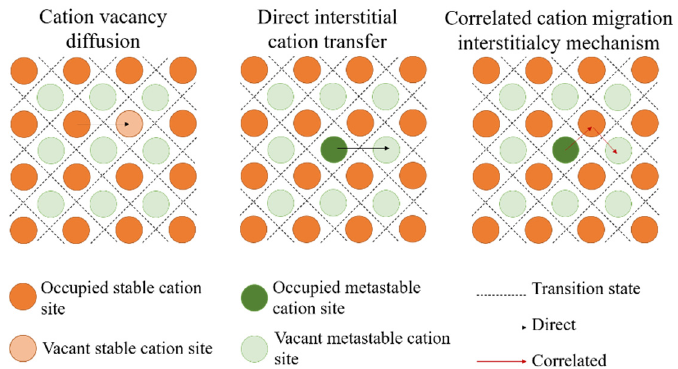
Figure 1. Three typical cation migration mechanisms: cation vacancy diffusion, direct interstitial cation transfer, correlated cation migration interstitialcy mechanism. Reprinted with permission from ref. [26]. Copyright 2019 Springer Nature.